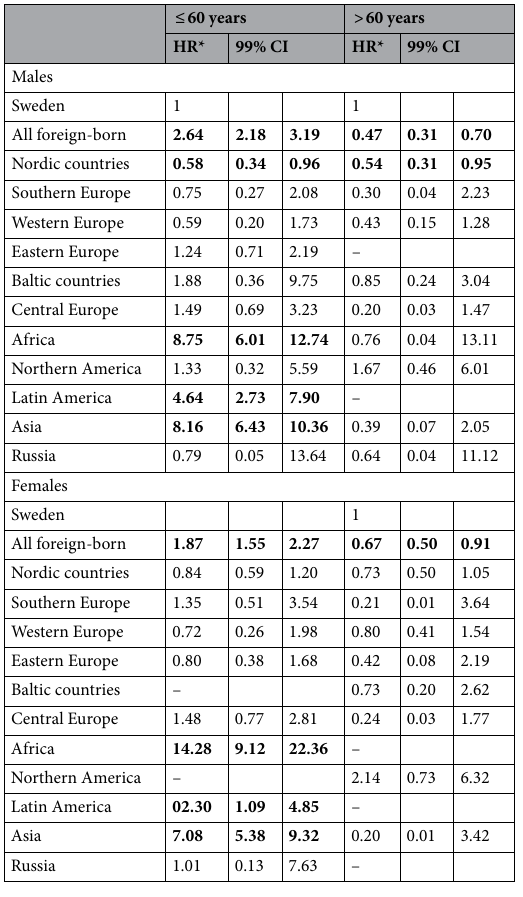
Table 5. The relative risk of post-polio in immigrants vs Swedish-born individuals categorized by age expressed as hazard ratios (HRs) with 99% confidence intervals (99% CI). *Fully adjusted. Bold values denotes statistically significant